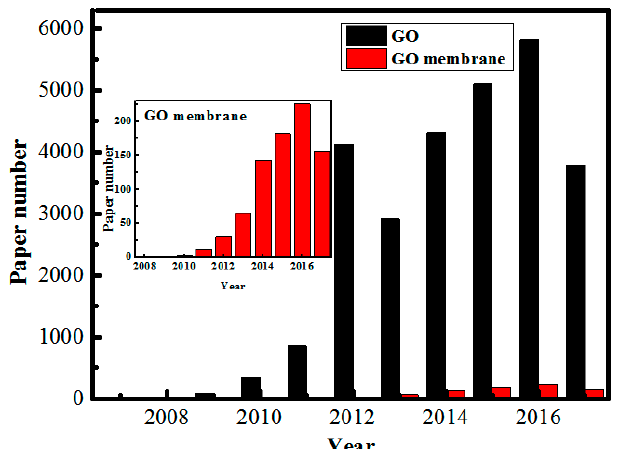
Figure 2. Numbers of publication for GO and GO-based membranes reported between 2008 and 2017 (topic keywords “graphene” and “graphene oxide membrane” searched from web of science), data updated by August, 2017.